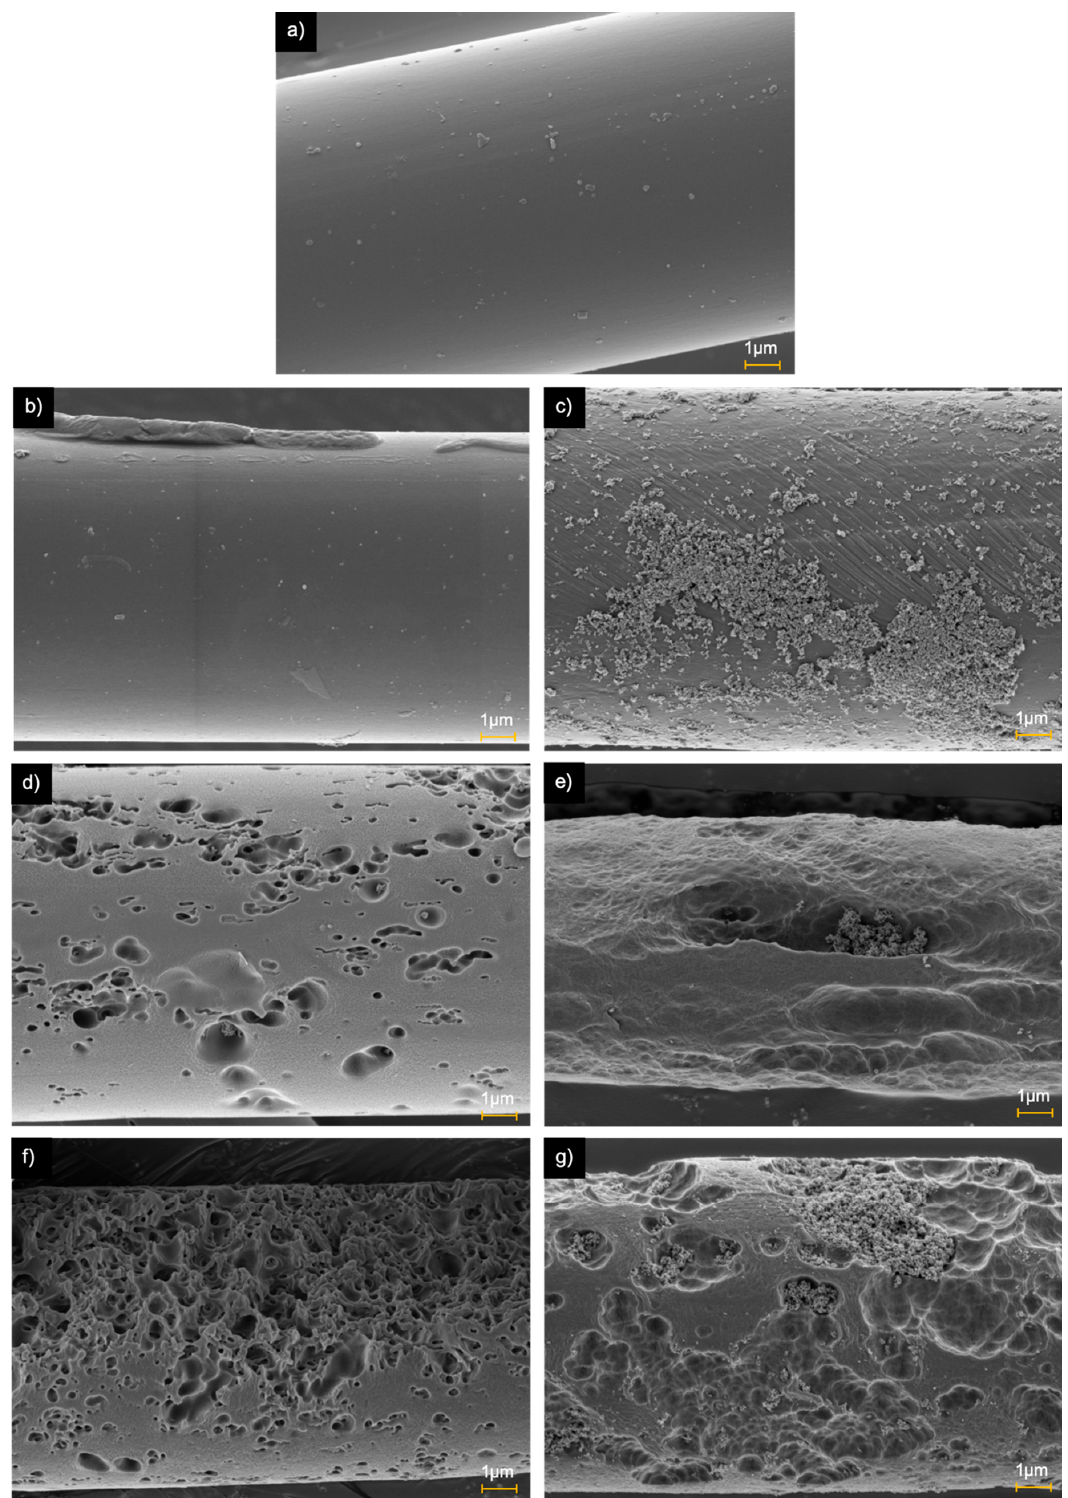
Figure 10. SEM micrograph of PA66 microfibres after different degradation conditions were applied for 105 h: ( a ) starting PA66 microfibres, ( b ) PA66 microfibres that had been suspended in deionised water; ( c ) in deionised water + TiO 2 , ( d ) in deionised water + UVA; ( e ) in deionised water + UVA + TiO 2 , ( f ) in deionised water + UVC, ( g ) in deionised water + UVC + TiO 2 . All images are taken at a magnification of 20.00 K.